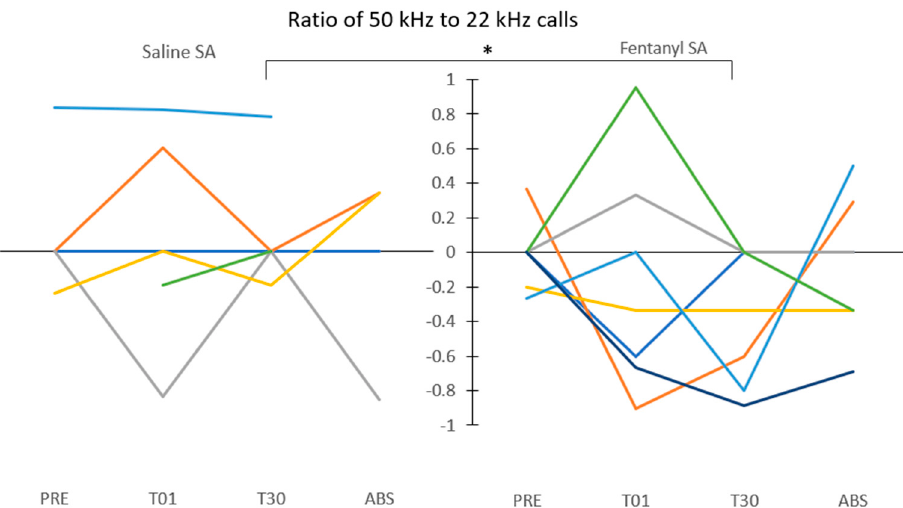
Figure 2. Ratio of 50 to 22 kHz calls. Tracking of all rats’ 50 kHz vs. 22 kHz calls across all sessions. Each line represents one rat. Y-axis = (B − A)/(B + A), where B is the rate of 50 kHz USVs and A is the rate of 22 kHz USVs. Thus, numbers above the horizontal line at zero represent a higher ratio of positive to negative calls; numbers below zero indicate a higher ratio of negative to positive calls; zero (horizontal line) indicates equal rates of the two calls. Note the absence of positive USVs and the prevalence of negative USVs in the 30th fentanyl SA session. The ratio did not differ between groups on T01, but the negative ratio of the fentanyl group was significantly different from the ratio of the saline group at T30; * p =